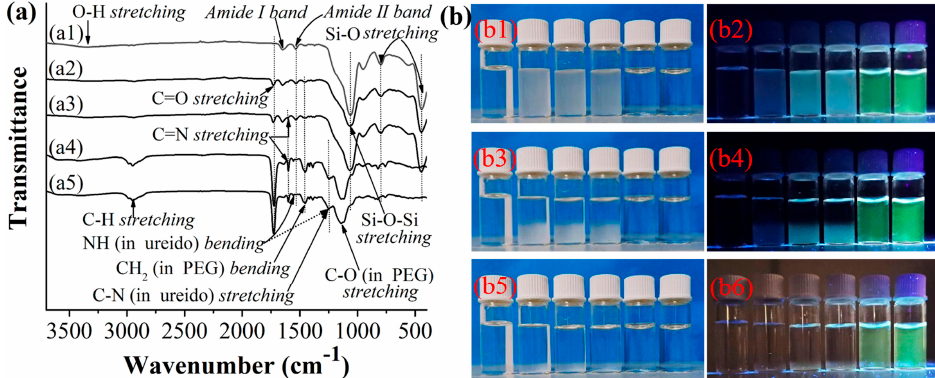
Figure 2. ( a ) FT-IR spectra of SiO 2 -Br ( a1 ), SiO 2 @NBD-MIP@PEG ( a2 ), SiO 2 @NBD-CP@PEG ( a3